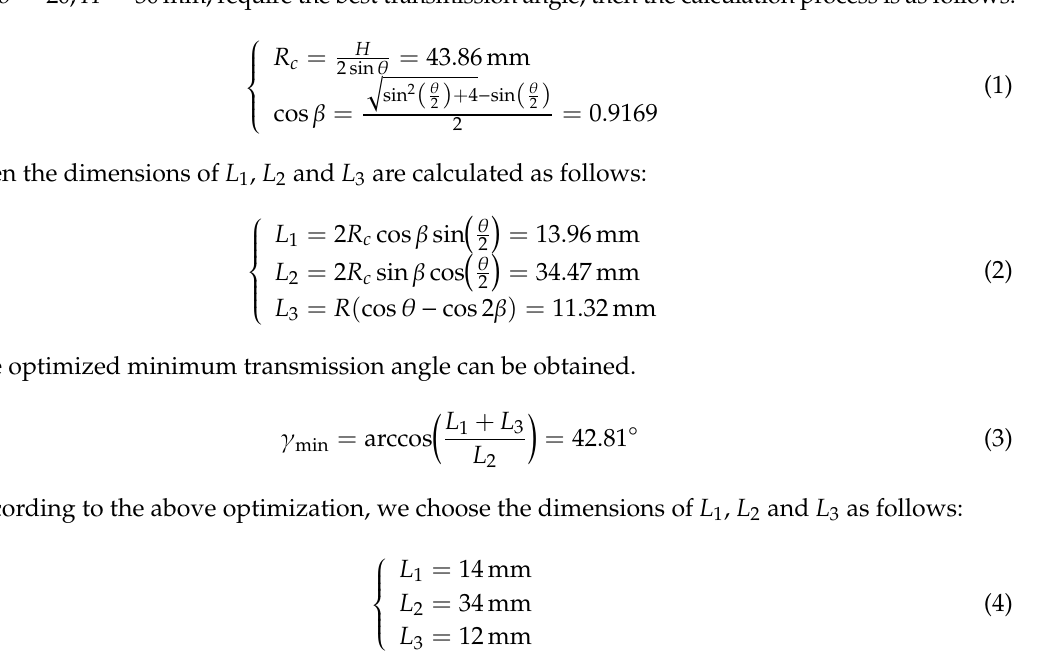
Table 1. Parameters of motor and reducer.